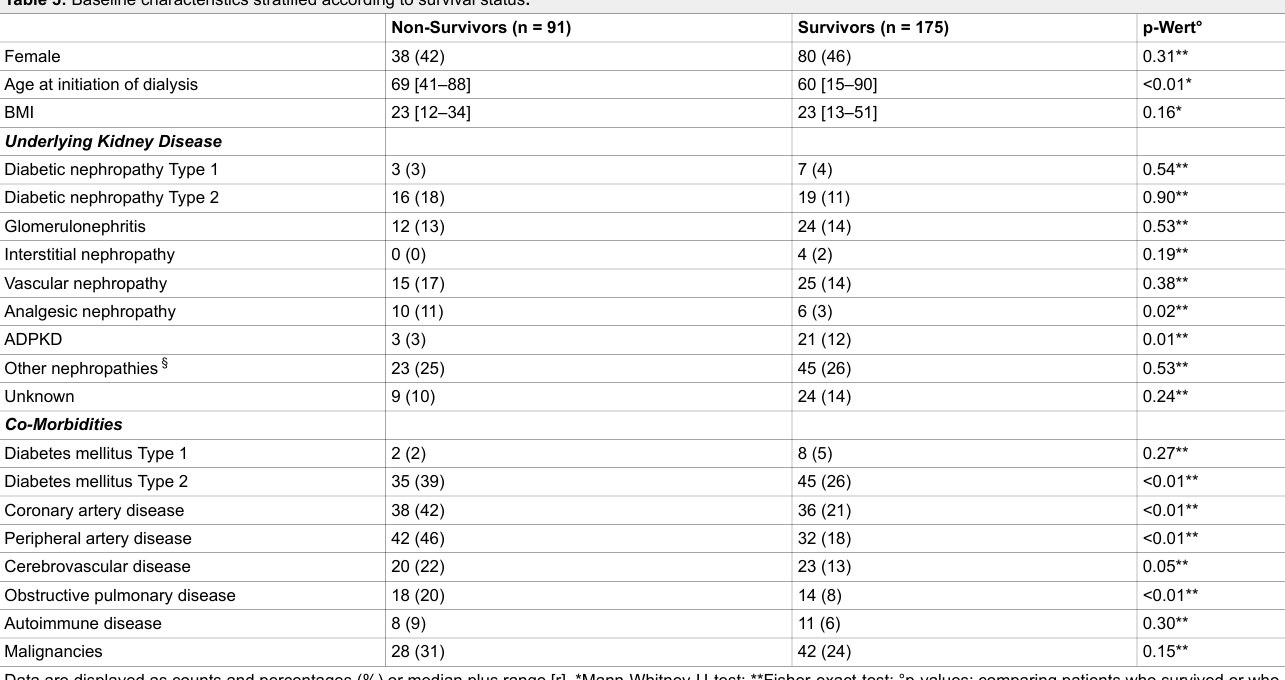
Table 5: Baseline characteristics stratified according to survival status .